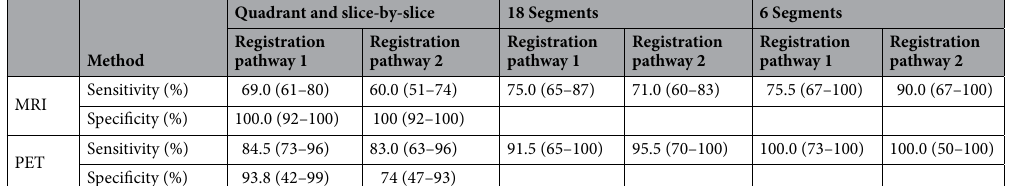
Table 1. Table 1 shows sensitivities and specificities both histological registration pathways and different analysis approaches for MRI and for PET.